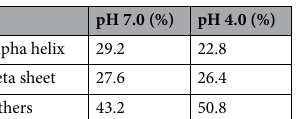
Table 1. Secondary structure content of hPrdx6 at pH 7.0 and